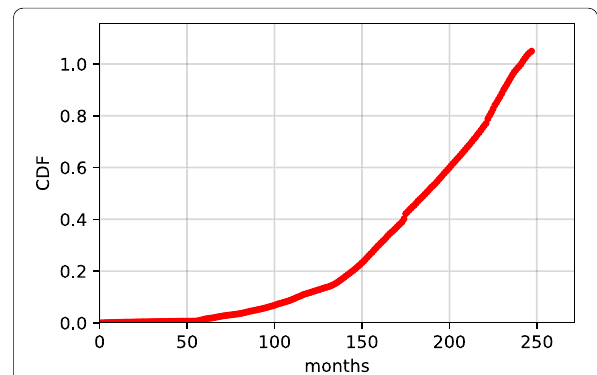
Fig. 3 The CDF of the number of cybersecurity reports published each